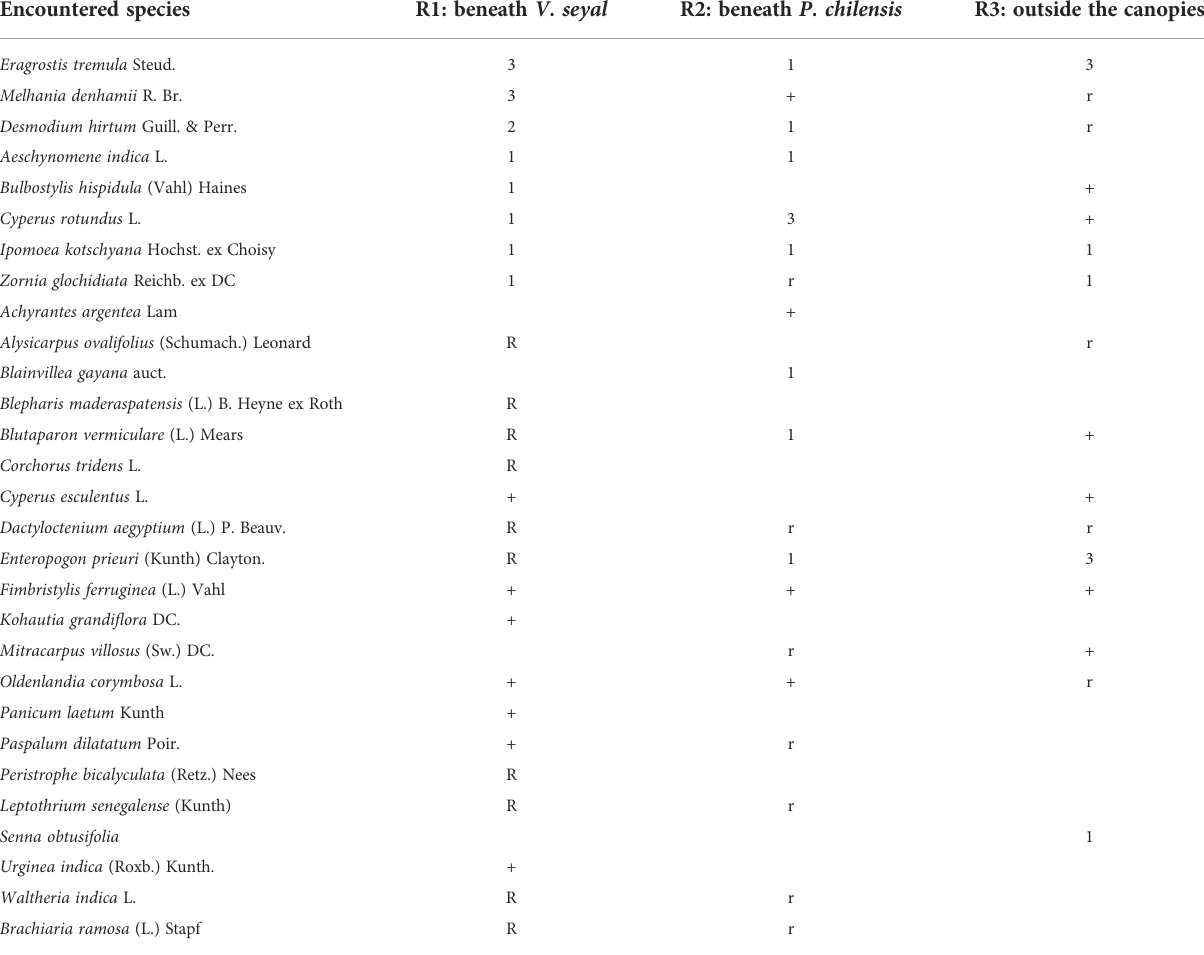
Rows: species; columns: surveys (R1, R2, R3); numbers, signs, and letters: index of abundance – dominance (Braun-Blanquet,